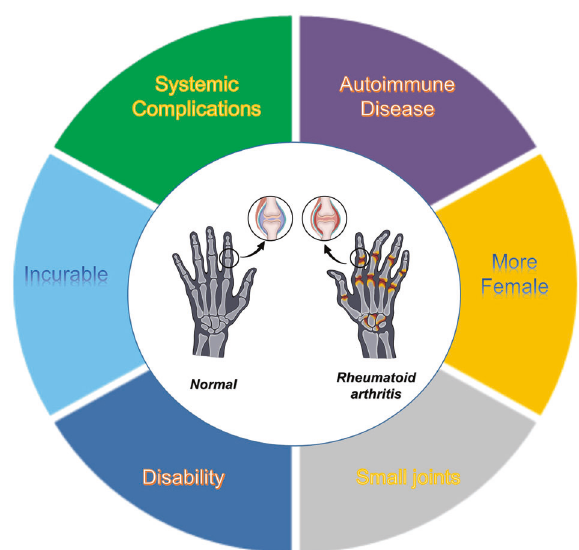
Fig. 1 General features of rheumatoid arthritis. Rheumatoid arthritis is an incurable autoimmune disease that occurs most frequently in women, usually in the small joints, with systemic complications that ultimately lead to across Europe: a Socioeconomic Survey (BRASS) by using Work Productivity and Activity Impairment questionnaire (WPAI) scores indicated that RA people with severe (60%) or moderate pain (48%) experienced additional work obstacles compared with those with mild (34%) or no pain (19%), a statistically remarkable correlation was found between severity, pain, disability, and early